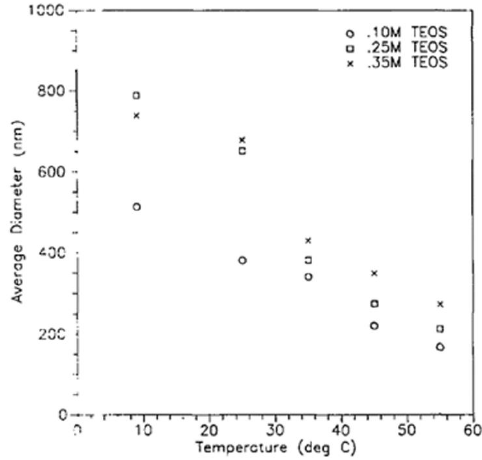
Figure 13. Relation between the temperature and particle size at different concentrations of TEOS. Reprinted with permission from [51]. Copyright Elsevier, 1998.